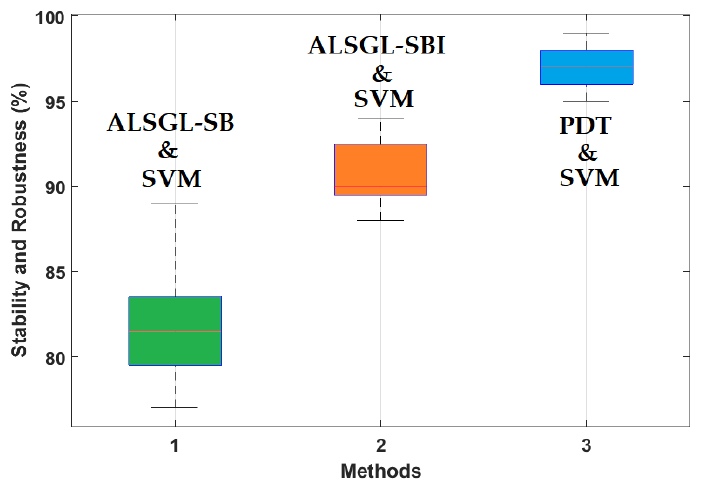
Figure 27. Test of reliability and robustness for crack size (3 mm and 6 mm) diagnosis using the combination of the ALSGL-SB and SVM approaches, ALSGL-SBI and SVM methods and the combination of the PDT and SVM procedures (20 times).